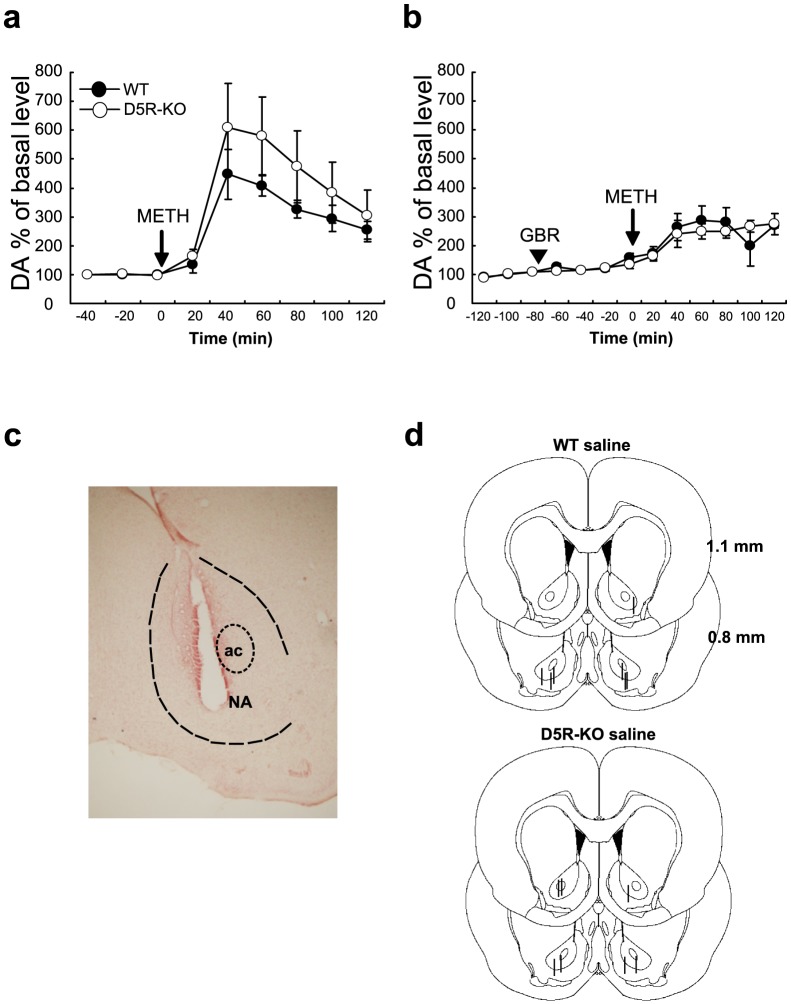
DAT levels in D5R-KO mice.(a) Dialysate samples were collected at a sampling rate of 2 µl/min for 20 min during a baseline period of 60 min and then for an experimental period of 120 min following the METH challenge (2.5 mg/kg; arrow). The interaction between blocker pretreatment and challenge was F(5,120) = 6.66 and p<0.0001. The simple main effects of blocker pretreatment at 40 and 60 min were F(1,144) = 13.50 and 8.08, and p<0.001 and p<0.001, respectively. WT, filled circles (n = 7); D5R-KO, open circles (n = 7). DA, dopamine. The arrowhead indicates the time point of saline injection. (b) Dialysate samples were collected for 20 min during a baseline period of 60 min. The animals were then injected with GBR12909 (5 mg/kg) and samples were collected for 20 min during a pretreatment period of 80 min. The animals were then challenged with METH (2.5 mg/kg) and samples were collected throughout the 120 min experimental period. The arrowhead indicates the GBR12909 pretreatment and the arrow indicates the METH challenge. (c) Representative microdialysis probe placements. Dashed lines denote the boundaries of the NA and the anterior commissure (ac). (d) Schematic representations of probe placements in the experimental groups for microdialysis of the NA at two different rostrocaudal levels (1.1 mm and 0.8 mm rostral from the bregma). The short lines indicate the probe tracks. Seven WT and seven D5R-KO probe track cases are overlaid on representative sections.